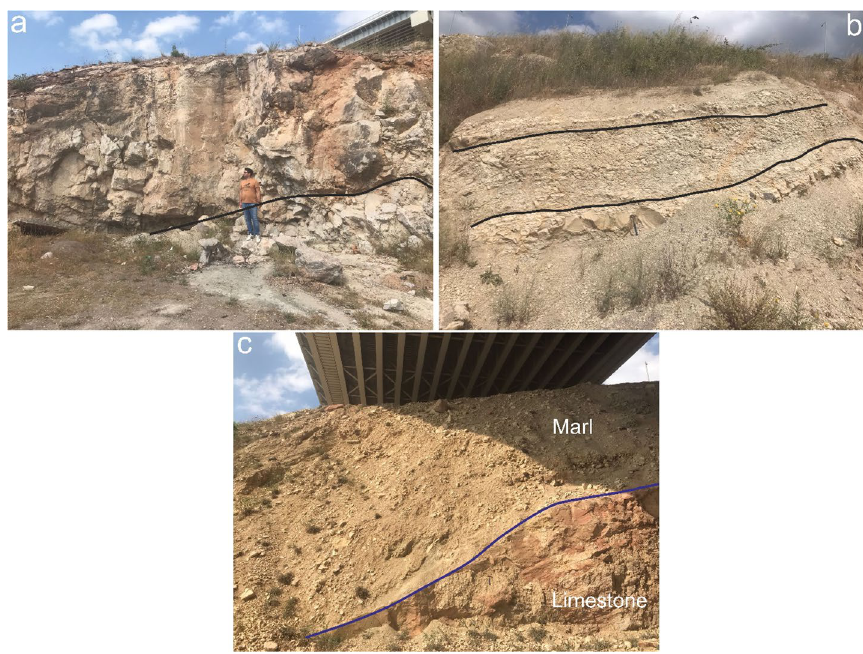
Fig. 3 Geological units observed around the tunnel ( a : dolomitic limestone, b : marl, c : boundary between limestone and marl, black line: layers, blue line: shear zone)